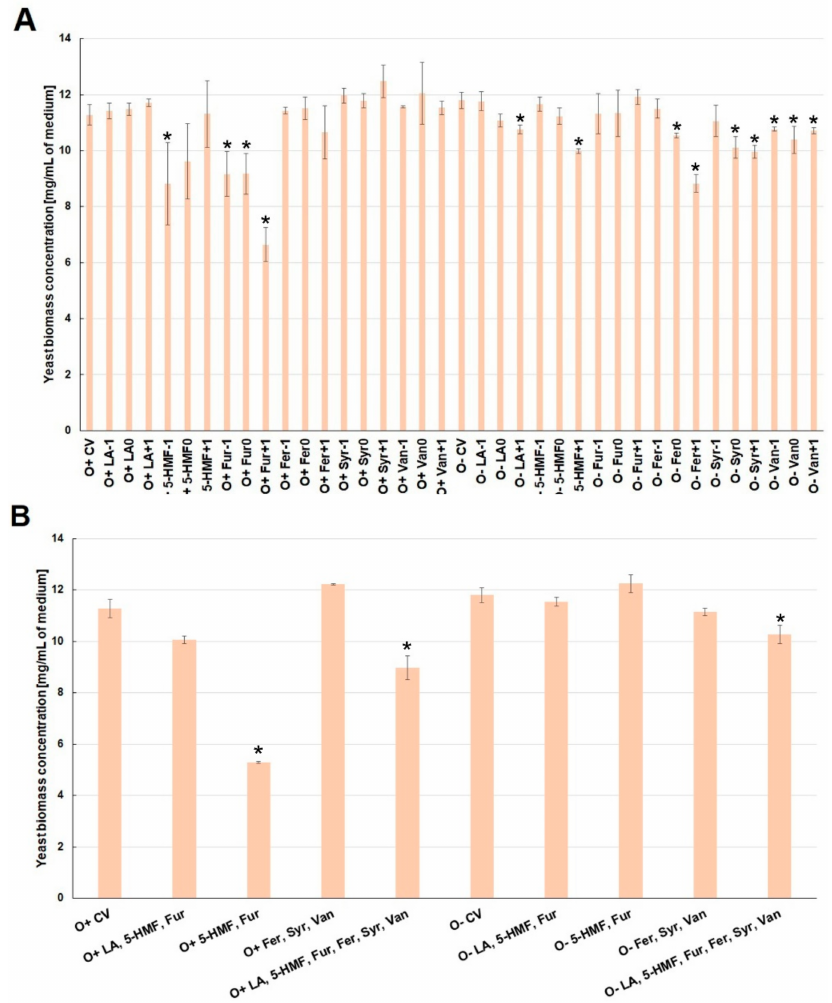
Figure 2. Effect of lignocellulose pretreatment by-products ( A , B ) on the yeast biomass production during the culture (*—statistically different from the corresponding control variant α <